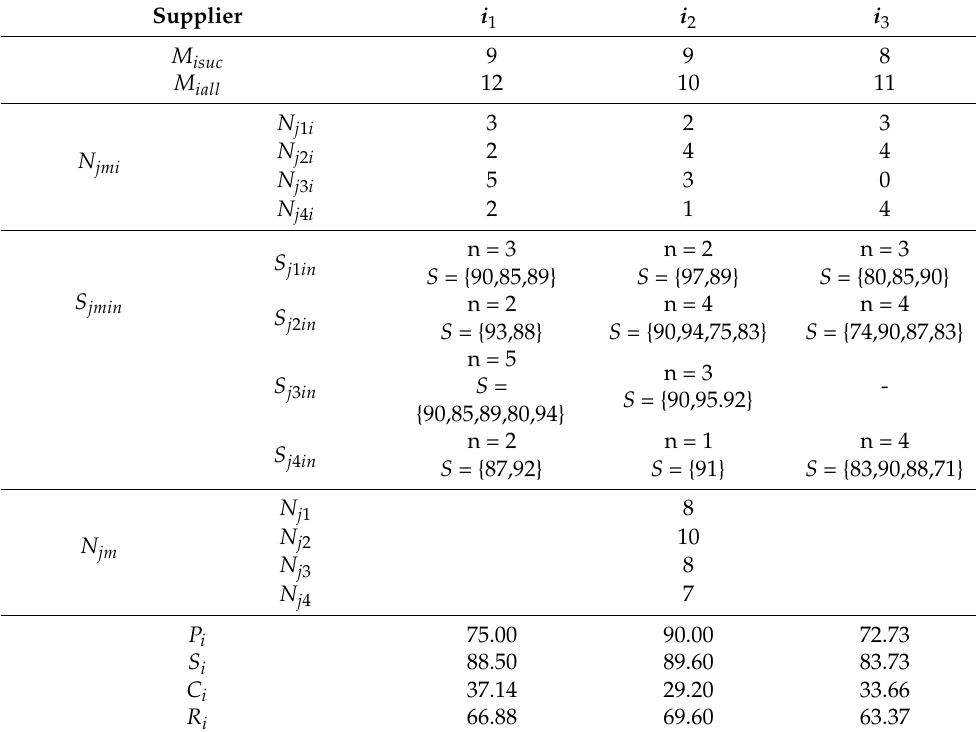
Table 1. Test data for reputation calculation